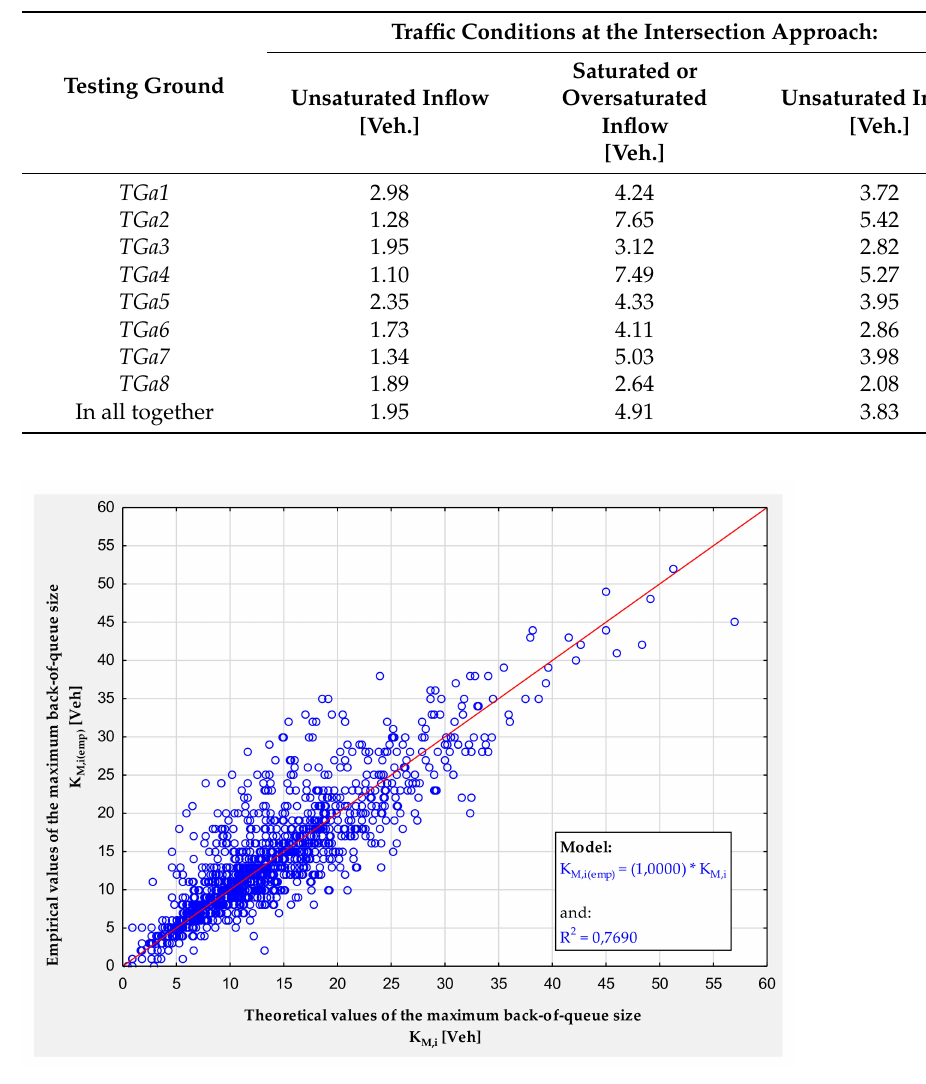
Table 4. Values of errors in estimating the maximum back-of-queue size at the signal-controlled intersection approach [Veh.] after calibration.